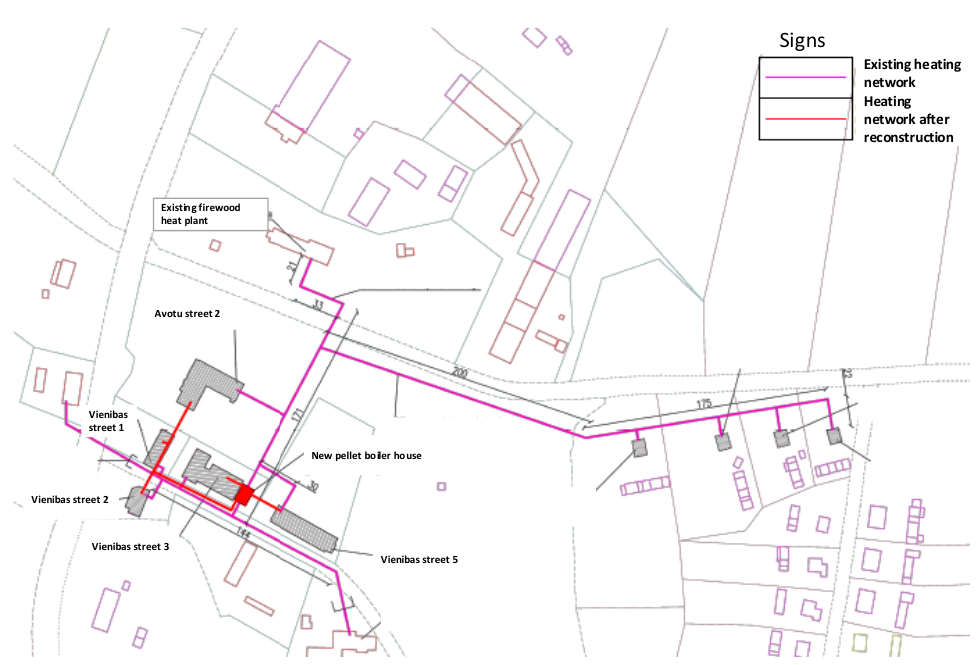
Fig. 1. Analysed DH network before and after reconstruction